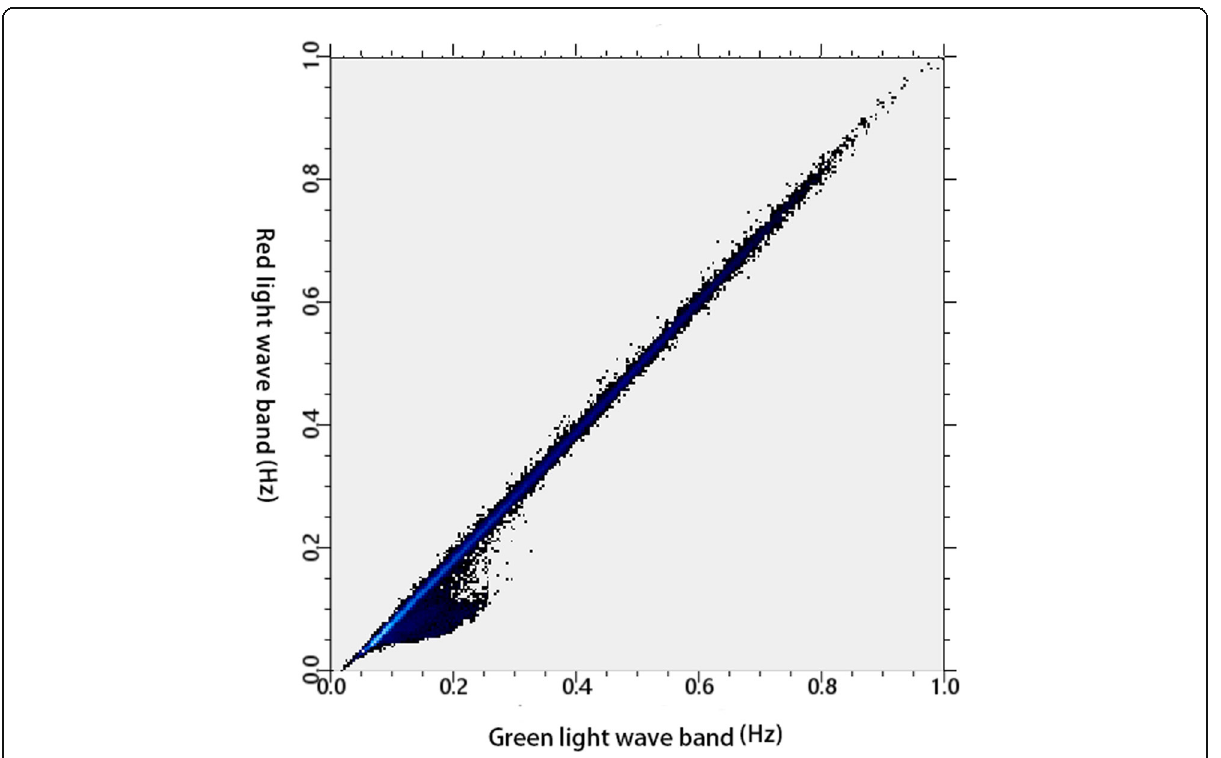
Fig. 11 The distribution of chlorophyll-a concentration in linear